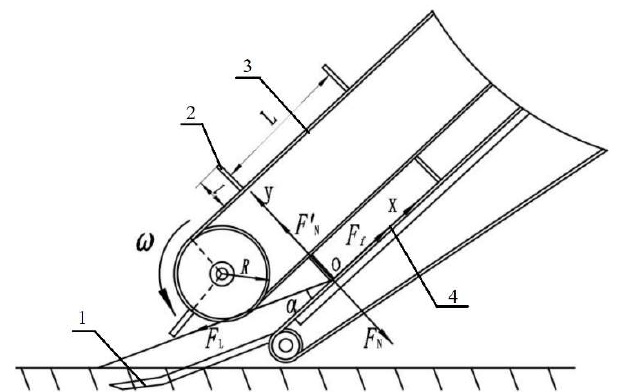
Figure 2. Analysis of clamp conveying force of residual film. 1. loosening shovel; 2. scraper; 3. the clamping plate conveying chain; 4. the residual film conveying chain. Where l = the height of clamp plate (cm); L = the spacing between two clamp plates (cm); w = the angular velocity of the clamp plate conveying chain wheel (rad/s); R = the radius of the clamp plate conveying chain wheel (cm).